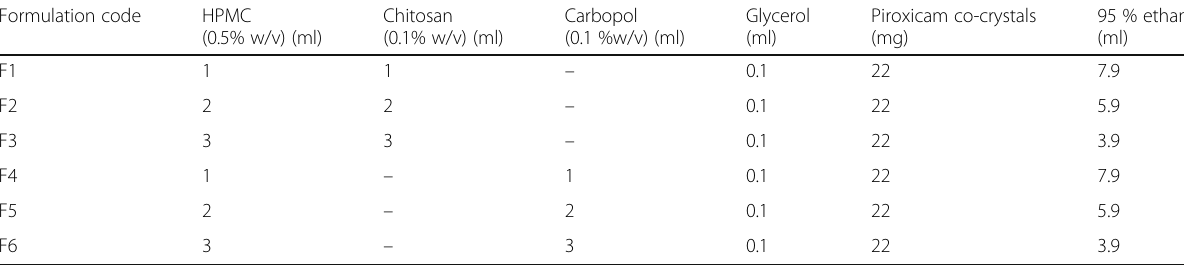
Table 1 Formulation of buccal film F1 to F6 Formulation